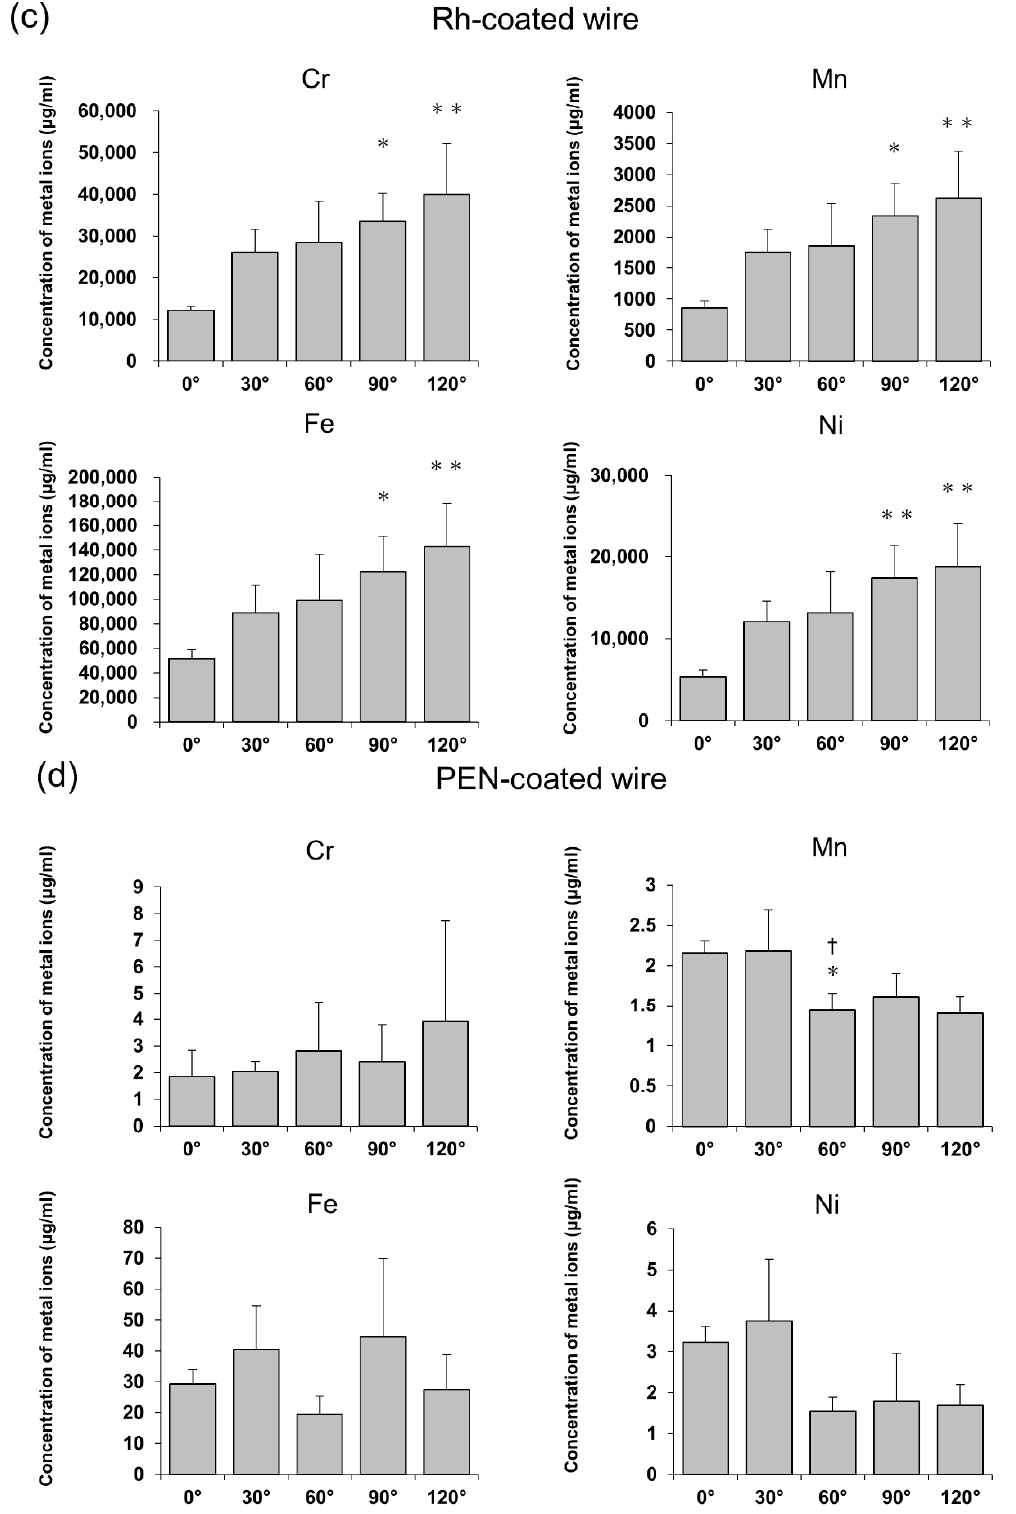
Figure 5. Metal ions derived from substrate metal, SS, released from four types of coated wire with various bend angles from 30° to 120° immersed in HCl. After immersion in HCl for 30 min, the amount of metal ions eluted from the wire was determined by ICP–MS. Concentrations of metal ions eluted from coated wire: ( a ) TiN-coated wire; ( b ) Au-coated wire; ( c ) Rh-coated wire; ( d ) PEN- coated wire. * p < 0.05 and ** p < 0.001 vs. 0°; † p < 0.05 and †† p < 0.001 vs. 30°; # p < 0.05 and ## p < 0.001 vs. 60°.